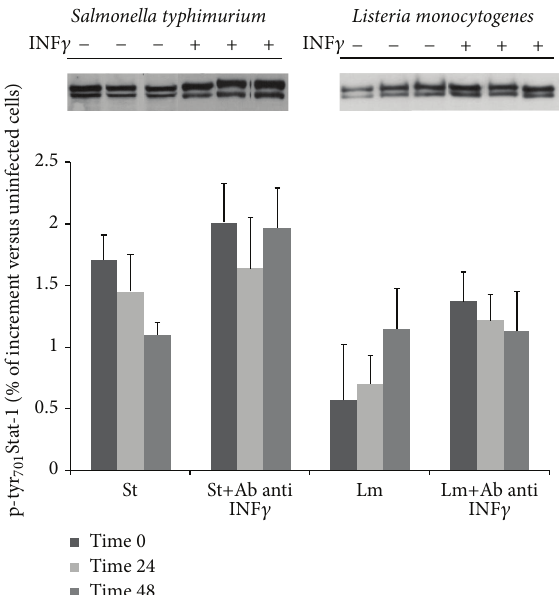
Figure 3: Densitometric analysis of p-tyr 701 Stat-1 expression levels in macrophages infected with Salmonella typhimurium (St) and Listeria monocytogenes (Lm). After infections, macrophages were cultured for 2 days in the absence or presence of 0.15 𝜇 g/mL of anti-IFN-gamma antibody and Stat-1 and p-tyr 701 Stat-1 expression levels were evaluated by Western blot assay at the indicated times. Data were the mean of three different experiments. The differences of the p-tyr 701 Stat-1 expression levels between infected and infected cells after INF-gamma blocking were not